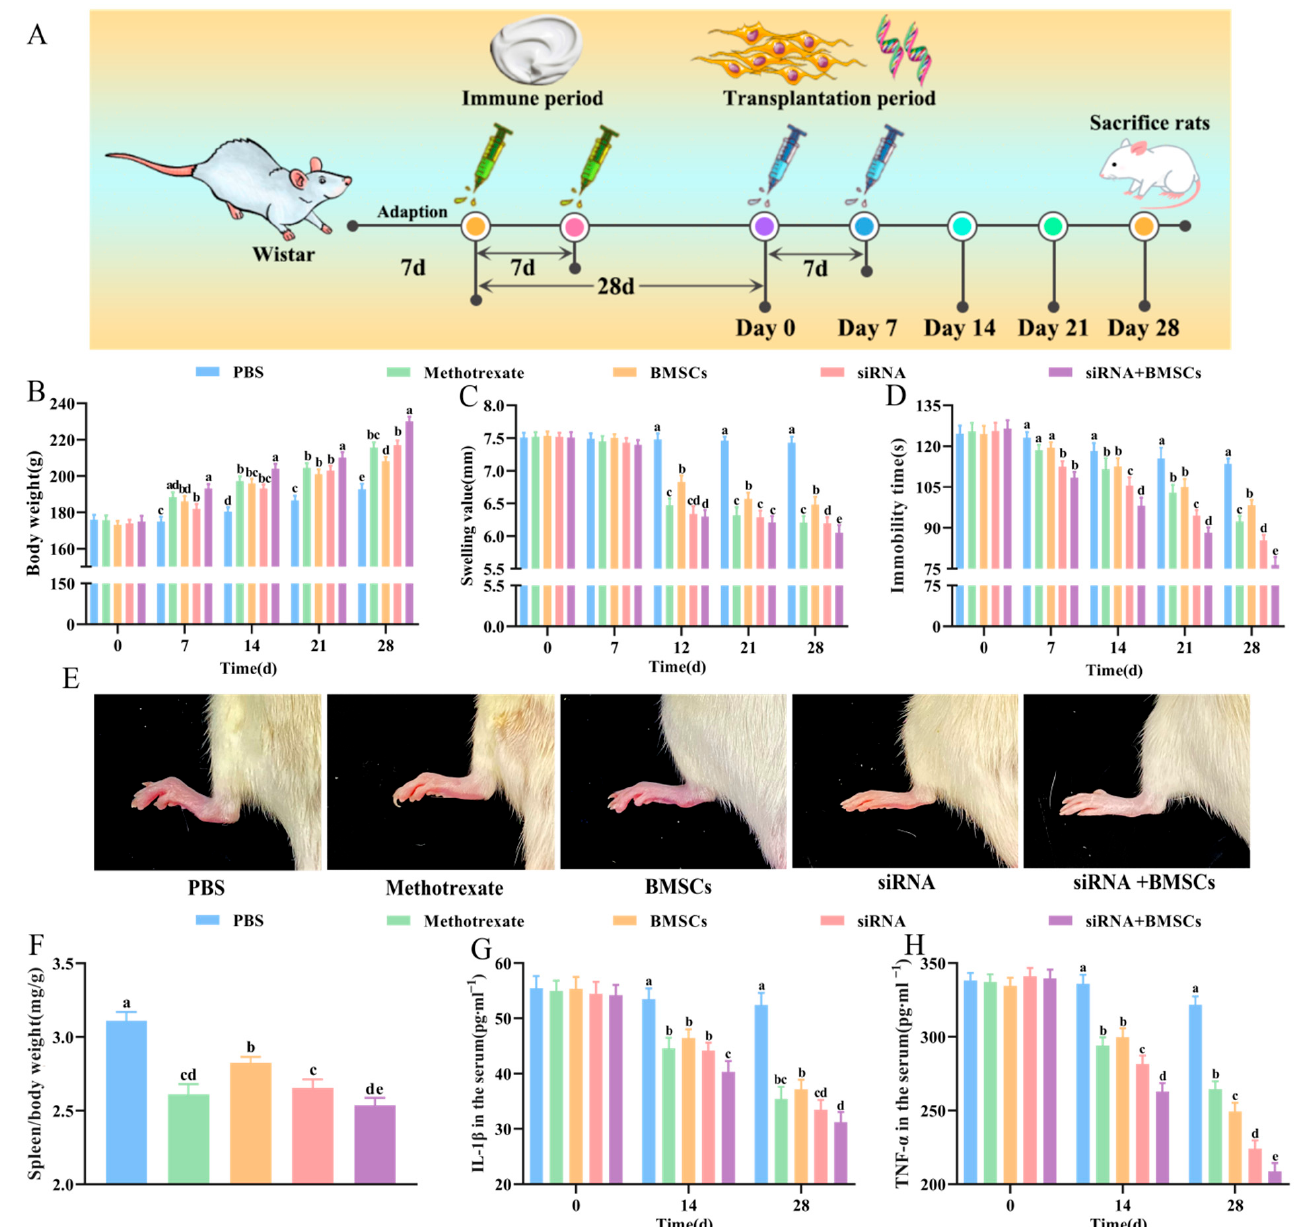
Figure 2. Effect of treatment with methotrexate, BMSCs, siRNA and siRNA + BMSCs on inflammation amelioration in CIA rats. ( A ), Timeline of immunization and therapy in rats. ( B ), Body weight. ( C ), Toe swelling. ( D ), The immobility time of forced swimming. ( E ), Toe swelling in CIA rats on the 28th day. ( F ), Spleen index. ( G ), Serum IL-1 β concentrations. ( H ), Serum TNF- α concentrations. Values are presented as the mean ± SD, n = 5/group. Different letters mean significant difference among different groups ( p <